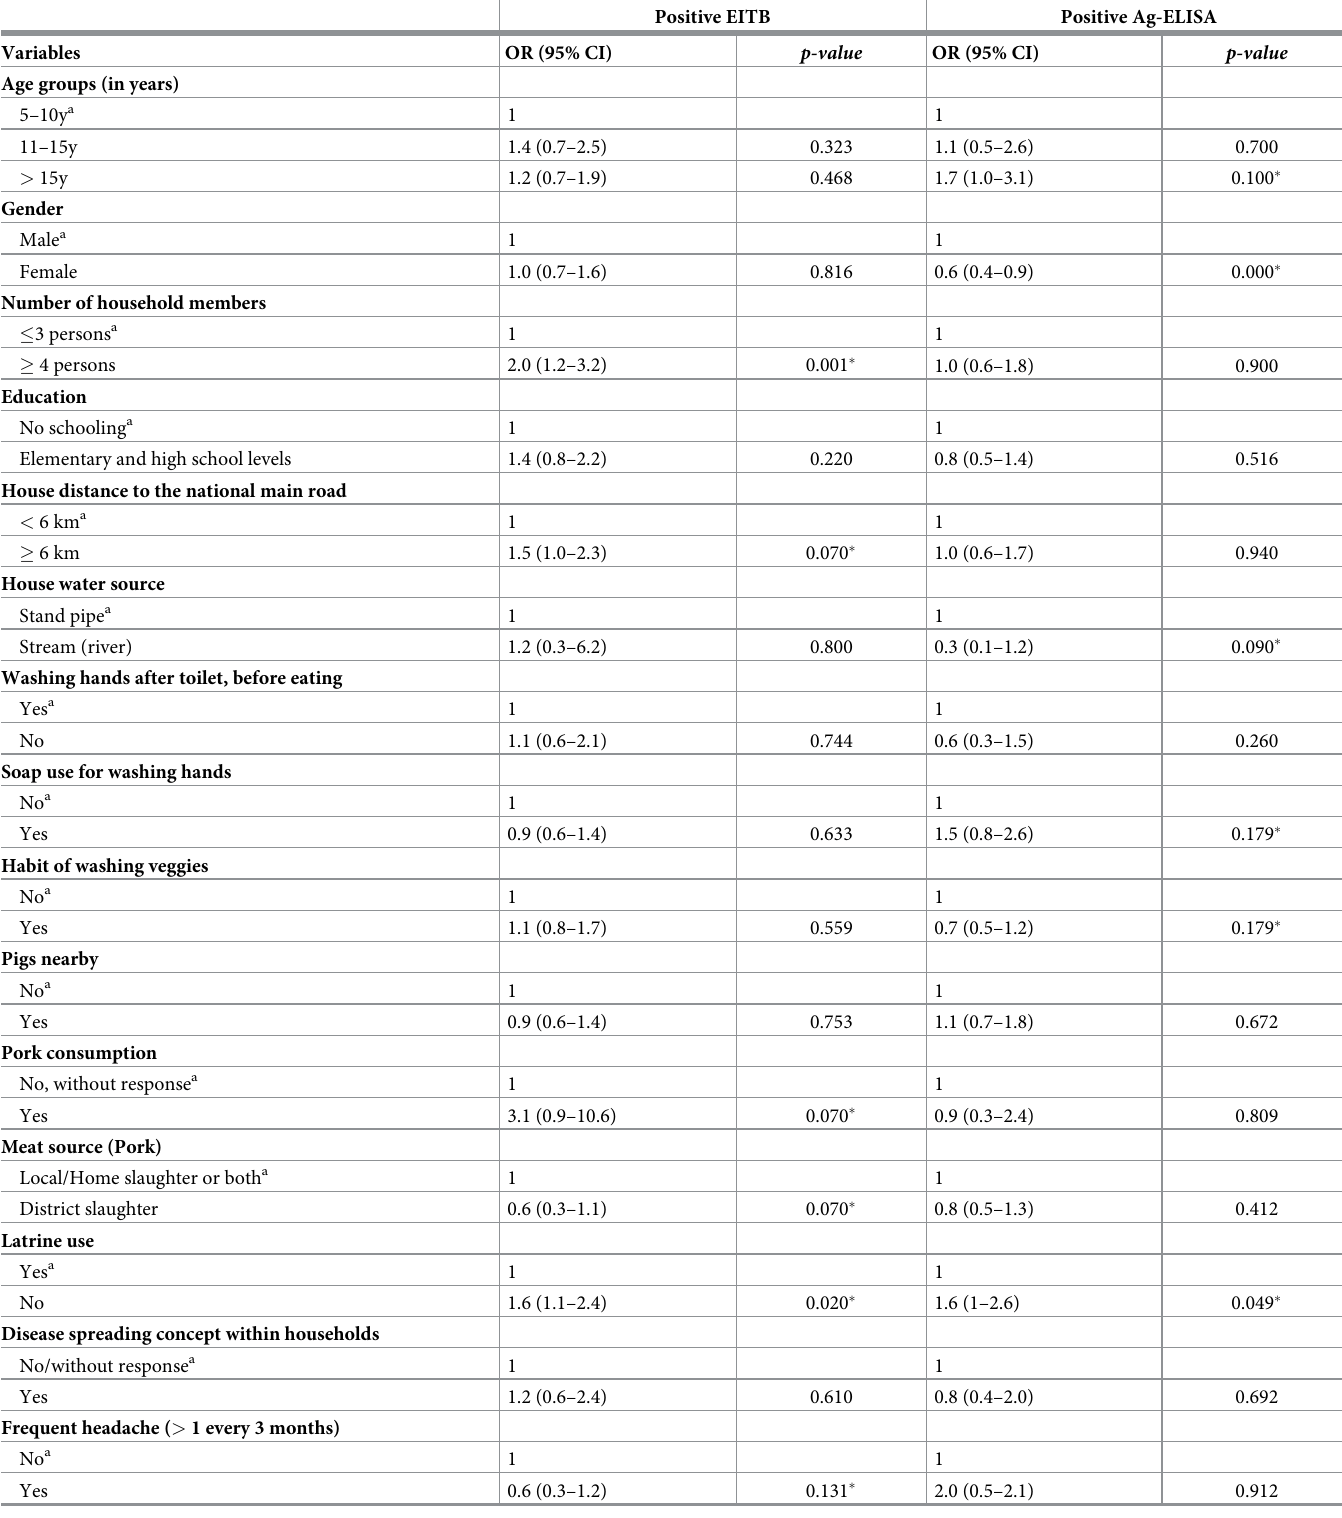
Table 4. Univariate analysis on risk factors and T . solium infections (positive EITB and Ag-ELISA